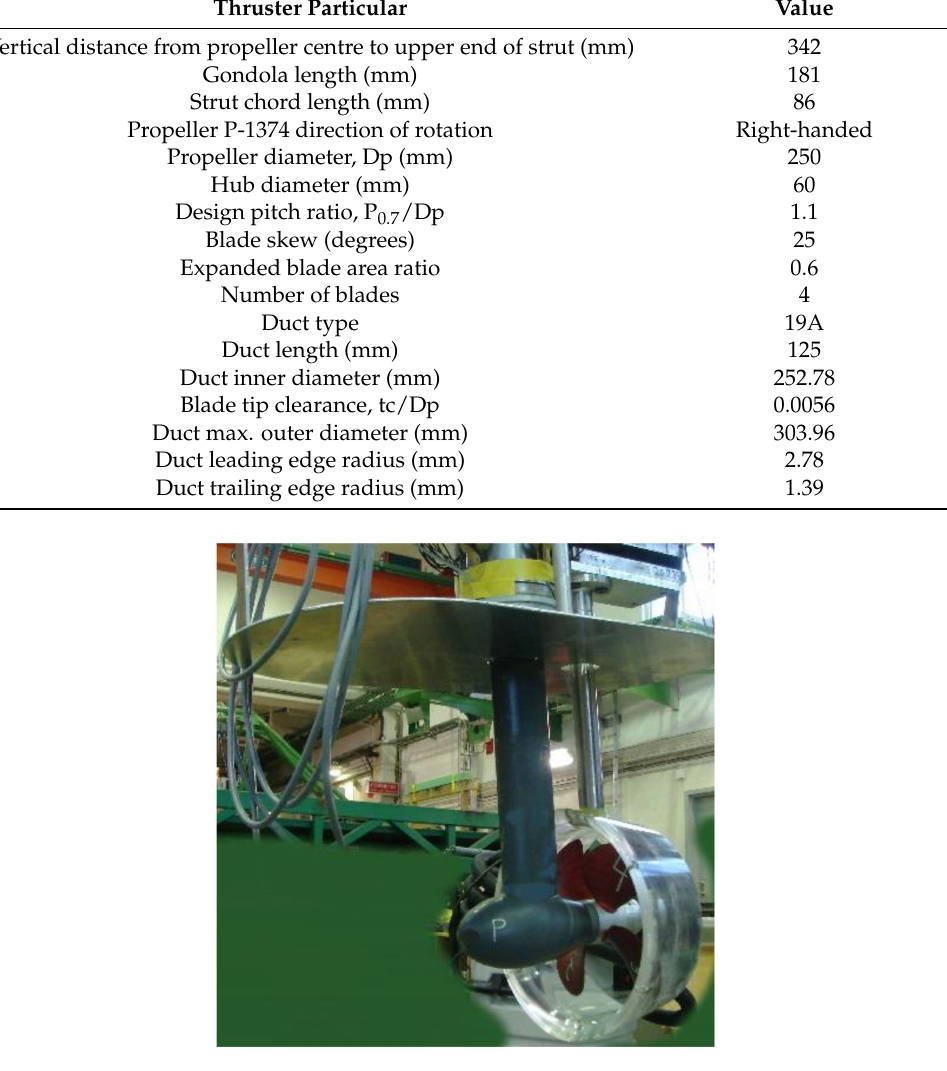
Figure 1. General view of model test